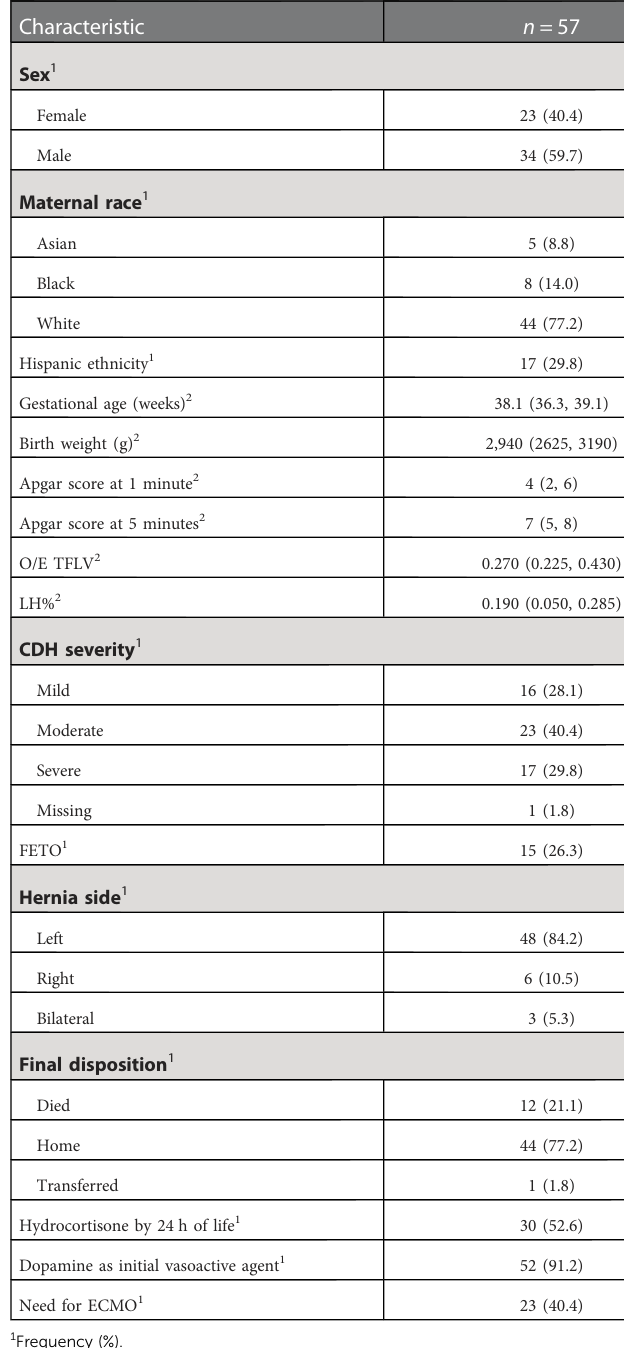
TABLE 1 Patient characteristics. TABLE 2 IS/VIS obtained in the fi rst 48 HOL as a predictor for need for ECMO and